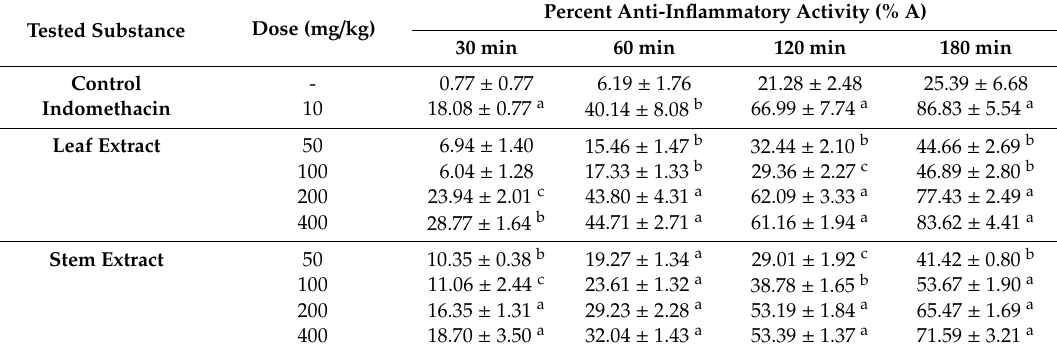
Table 3. E ff ects of leaf and stem extracts of U. bojeri on carrageenan-induced mouse paw edema (n = 5). Tested Substance